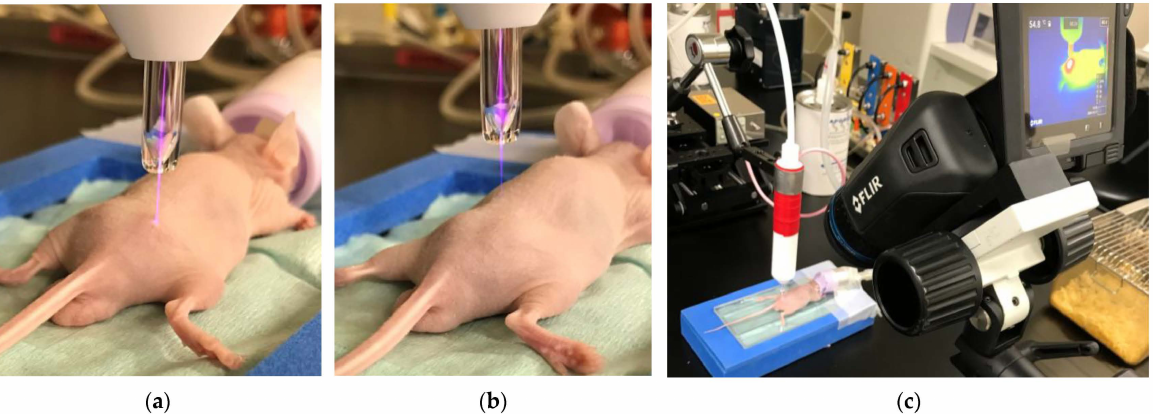
Figure 2. Photographs show: ( a ) low-temperature atmospheric-pressure helium microplasma jet treating a live mouse as an example of contact plasma treatment; ( b ) non-contact plasma treatment; and ( c ) the complete experimental set-up with the position of the thermography camera to measure skin